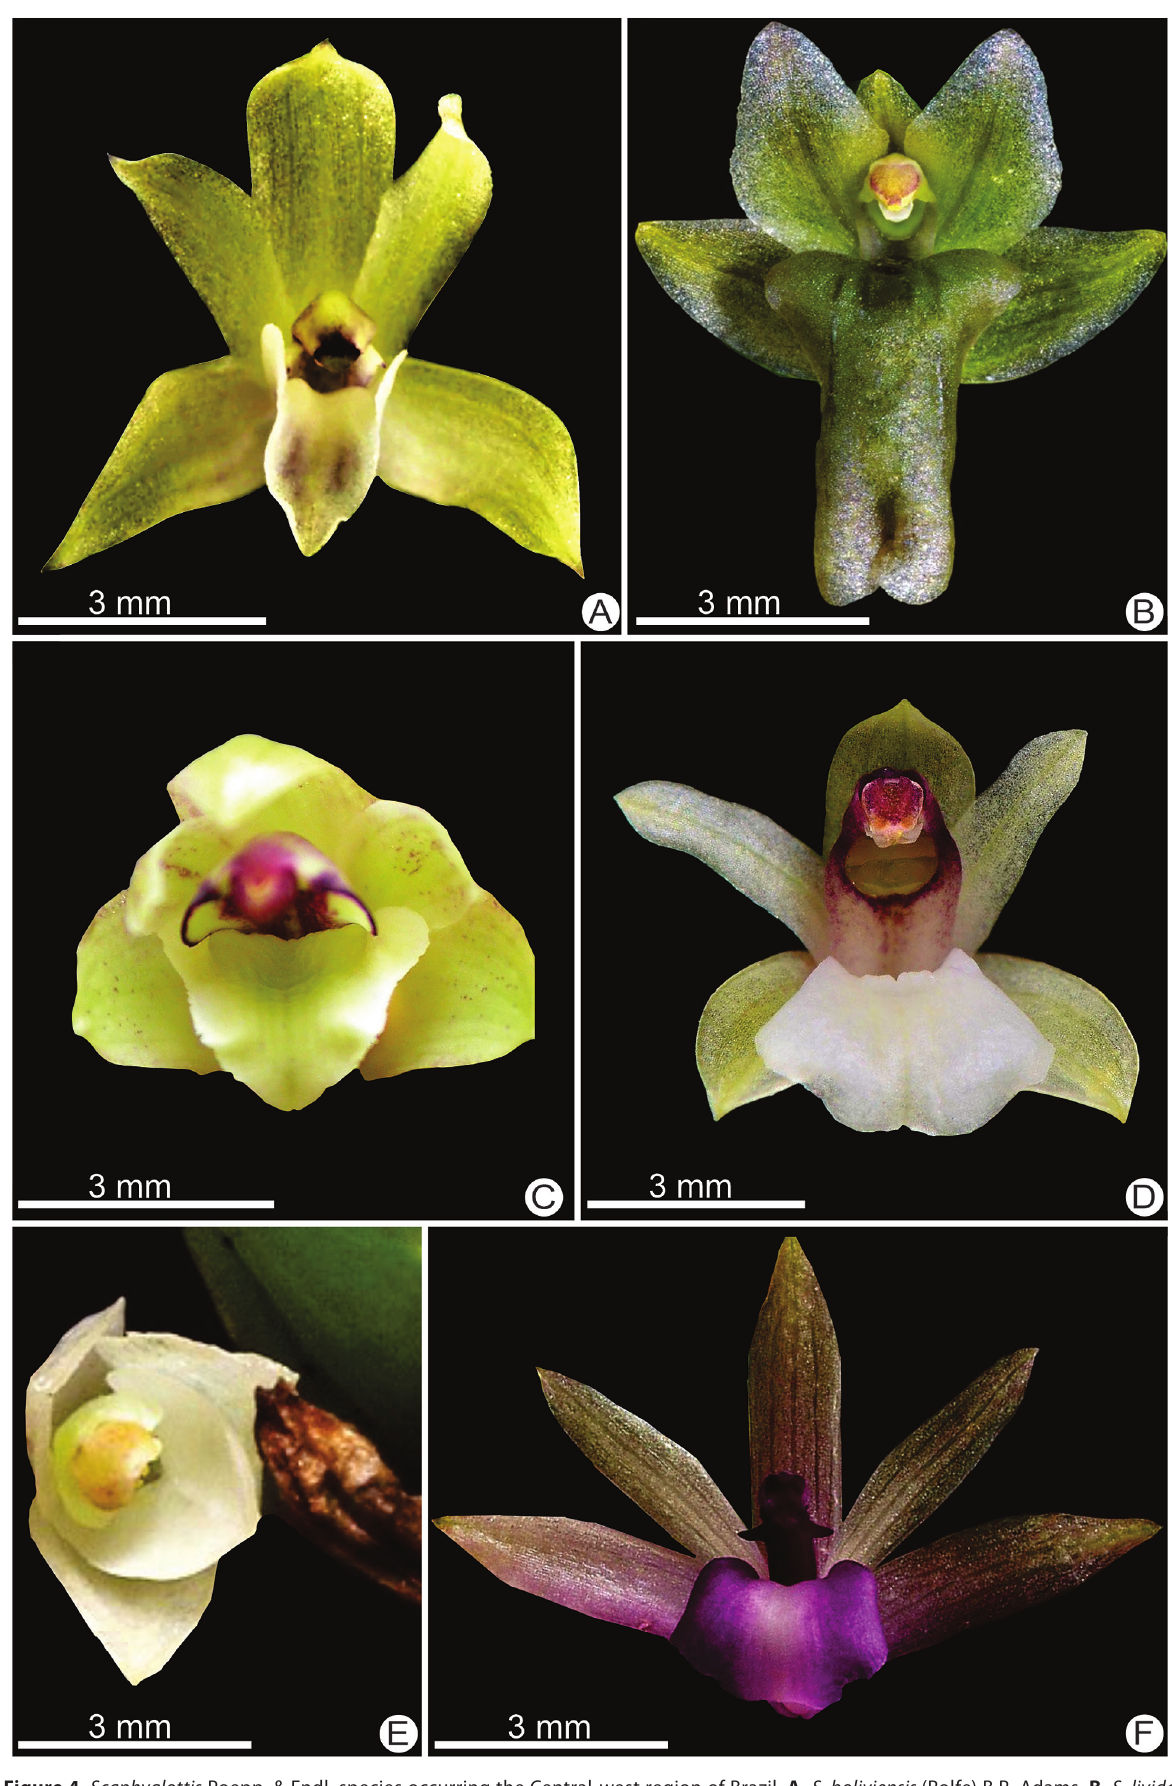
Figure 4. Scaphyglottis Poepp. & Endl. species occurring the Central-west region of Brazil. A. S. boliviensis (Rolfe) B.R. Adams. B. S. livida (Lindl.) Schltr. C. S. modesta (Rchb. f.) Schltr. D. S. prolifera (Sw.) Cogn. E. S. sickii Pabst. F. S. stellata Lodd. ex